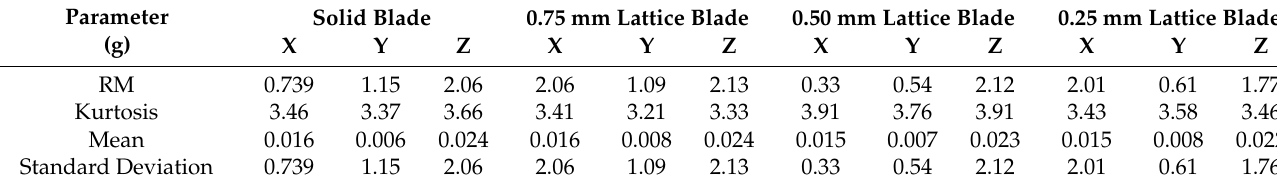
Table 5. Statistical analysis of measured vibration signals.